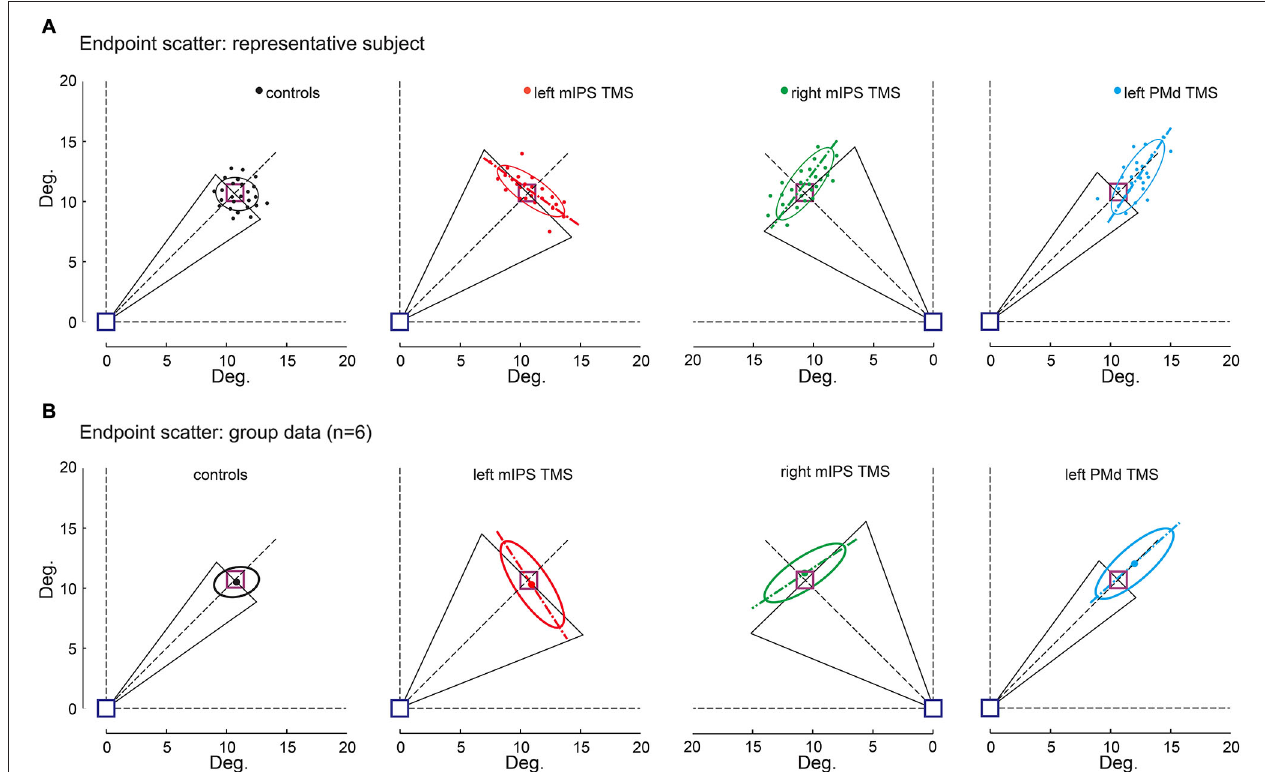
square). This figure clearly illustrates the distinct effects of TMS applied over mIPS and PMd on movement direction and amplitude, respectively. Left and right mIPS TMS increased the endpoint scattering along a direction orthogonal to the optimal movement path (45 ◦ dotted lines) for targets located in the contralateral hemifield, reminiscent of an error in computing the appropriate movement direction. TMS applied over the left PMd led to an overshoot and increased the spread of endpoints along the optimal movement path to reach the targets, irrespective of their location in the right or left hemifield; this effect is illustrative of an inappropriate amplitude programing. (A) Representative subject, each dot represents an individual trial. (B) Average ellipses across all subjects ( n = 6). The dot represents the center of each average